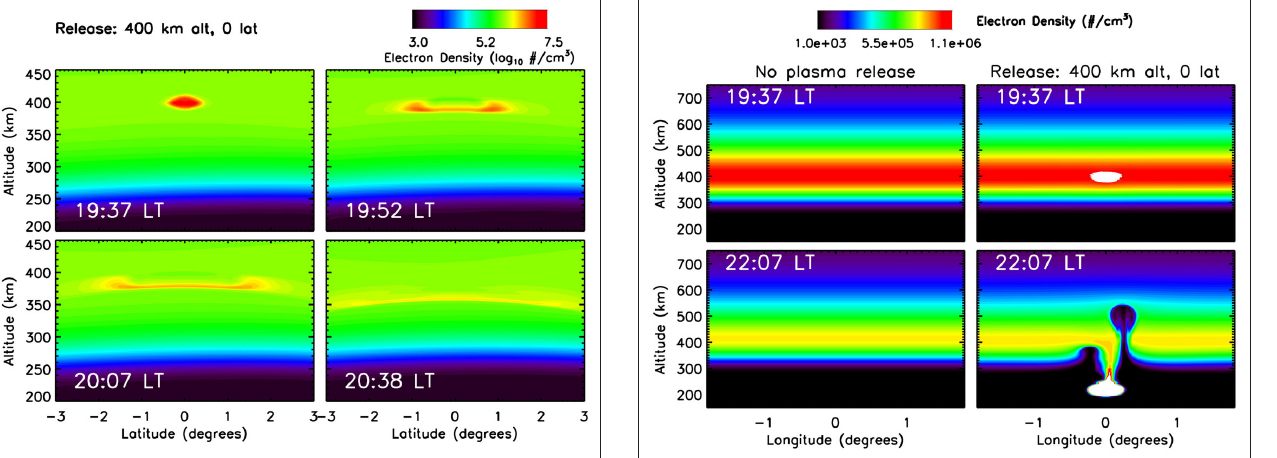
FIGURE 5 | Electron density (log 10 cm − 3 ) as a function of longitude and altitude at 0 ◦ latitude for two different simulations (Left, Right) at two different times (top and bottom) . The left panels show the time evolution for the background simulation with no plasma release; in this case no ESF develops. The right panels show the case where a plasma release is simulated at 400 km altitude and 0 ◦ latitude. Note that the color bar saturates in the area of the plasma release. As shown in Figure 3 the plasma release spreads along the field line and then drifts downward. The bottom right panel shows that after several hours ESF bubbles develop in the ionosphere as a result of the plasma